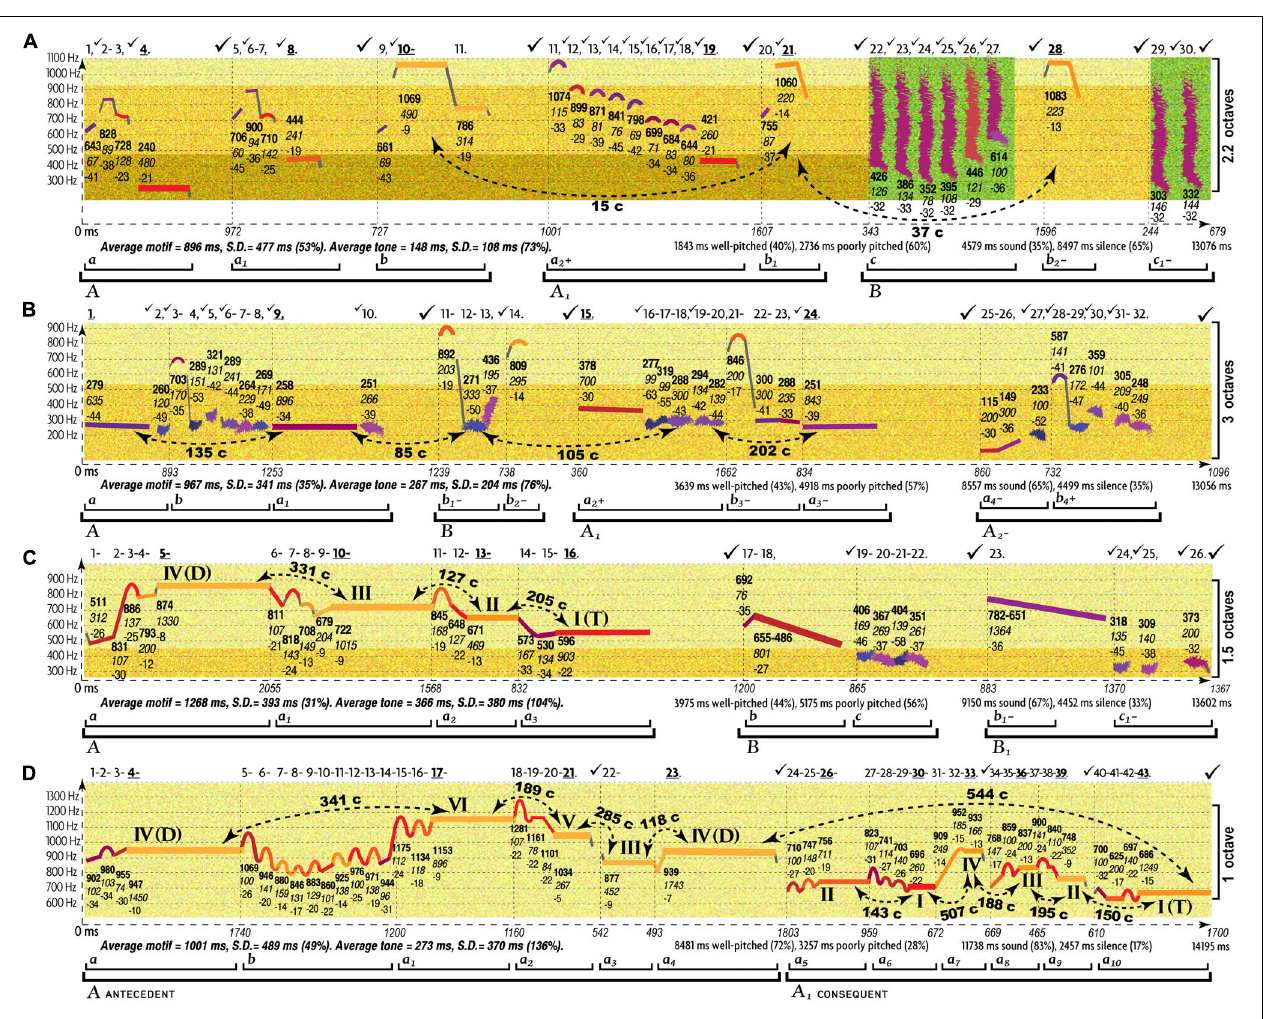
FIGURE 7 | Patterns of TO in four main types of vocalization in the vocal tradition of kulning. Since kulning is essentially ametric and averbal (except for the closest range recitative), its analytic charts omit lyrics. Unlike the previous figures, the vertical dash lines indicate the onset of motifs. The colored arc-line symbol represents an ornamental melismatic shake. (A) Stimulative medium-distance kulning: parlando (a), exclamation (b), and onomatopoeia (c) motifs (http://chirb.it/ntIxfM). This style is designed to compel the entire herd to move in the desired direction and, most probably, sets a model of interaction with animals for the other three styles. The three motifs achieve stimulation, each in a different way, contrasting one another in register, harmonicity, rhythm, and articulation. Motif “a” alerts by its staccato zigzag leaping between two registers. Motif “b” combines stimulation (staccato leap up to the “shrieking” register) with relaxation (legato leap down to the long tone). The “shrieking” peak-tones maintain the same pitch level (melodic regularity)—reflected by the dotted double-arrows (numbers indicate the frequency discrepancy in cents). Motif “c” teases the cattle by imitating dog’s barking. The stimulative specialization of (A) is manifested in its prevalence of staccato, loud dynamics, three registers within a wide ambitus, exuberance of leaps, and briefness of motifs and tones. Noteworthy, the motifs “a 2 ” and “c” resemble the “fetch-command” archetype ( Figure 5E ). (B) Stimulative close-distance kulning: recitative (a) and motherese (b) motifs (http://chirb.it/8K3Lqg). (B) , like (A) , is stimulative but dynamically gentler due to closer distance ( ≈ 9 dB softer). This allows for diverse motherese-like prosodic exaggerations in motivating individual animals. Motif “a” expresses love/care by greatly prolonging the “recitative tone,” sustaining its pitch and harmonicity. Motif “b” stimulates animals by briefly stressing the upper “head-voice” register with a shake-like embellishment, then sliding it all the way down to the low talking voice. Compared to (A) , (B) is smoother: fewer registers, less staccato, and longer motifs and tones. (B) tends to support a monotone (a predecessor of tonicity), most noticeable at phrasal ends. (C) Inhibitive longer-distance kulning: simple kula (a), exclamation (b), and parlando (c) motifs (http://chirb.it/n6f0sv). This style functionally opposes (B) by commanding the herd to stop grazing and to go home, implying that it is no longer safe to stay out. The chief function of “a” (kula) is to instill confidence in the herder’s control over the animals. “Kula” typically consists of a chain of motifs stitched together to form a characteristic shape of steep ascension to the crest point and thereafter a gradual fall-off. However, motifs might differ according to their phrasal functions: initiation, climax, decay, and cadence. The resulting kula receives a basic modal TO: anchor tones constitute “degrees” of the mode, forming a fifth between the marginal degrees and dividing it in wider upper and narrower lower parts. The Roman numerals indicate degrees (I = stable is marked as T = “tonic”). The “b” motif presents “exclamation”: a gradual sliding down ( ≈ 4th), softer than in (A) , and shaped like the “stop-command” ( Figure 5E ). Similarly shaped is the parlando “c” motif, much smoother than (B) due to its prevailing legato, freer rhythm, more homogenous registers, and longer motifs and tones. (D) Tropotrophic maximal-distance kulning: exclusive use of complex kula sentences (http://chirb.it/gpyC7t). Delivering signals over a kilometer requires taking multiple short caesuras throughout the span of the kula’s descending formula, which distinguishes (D) from (C) by making kula complex. Motifs make up phrases, and phrases—sentences, all of which create modal complexity: anchor-tones form intervallic relations that define degrees within a mode (usually, 5–7 degrees). Upper degrees open kula, forming an antecedent cadence (marked by letter “D”—“dominant” function). Lower degrees end kula with the consequent cadence (marked by “T”—“tonic”), providing resolution.